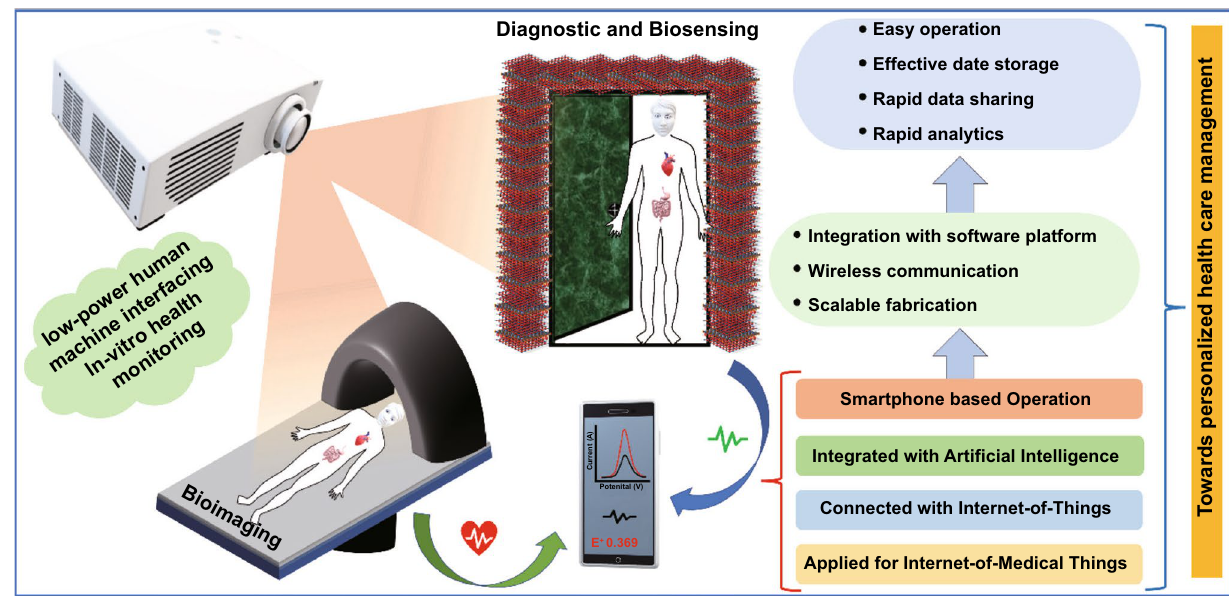
Fig. 10 Futuristic application of MXene toward personalized healthcare